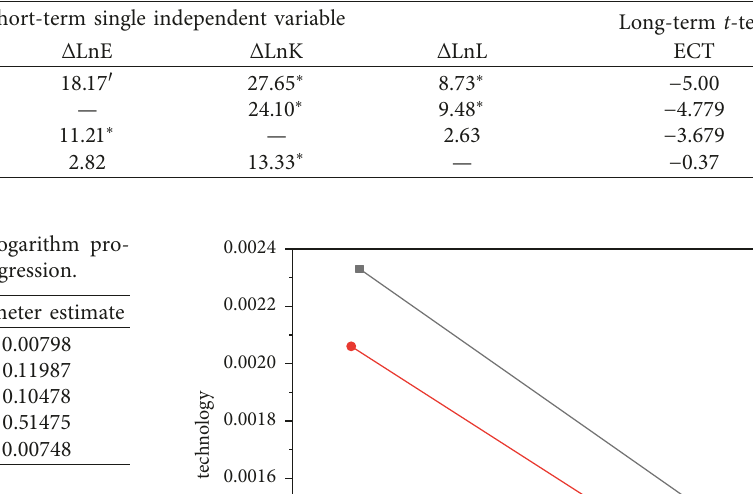
Table 7: Causal test results based on vector error correction model.